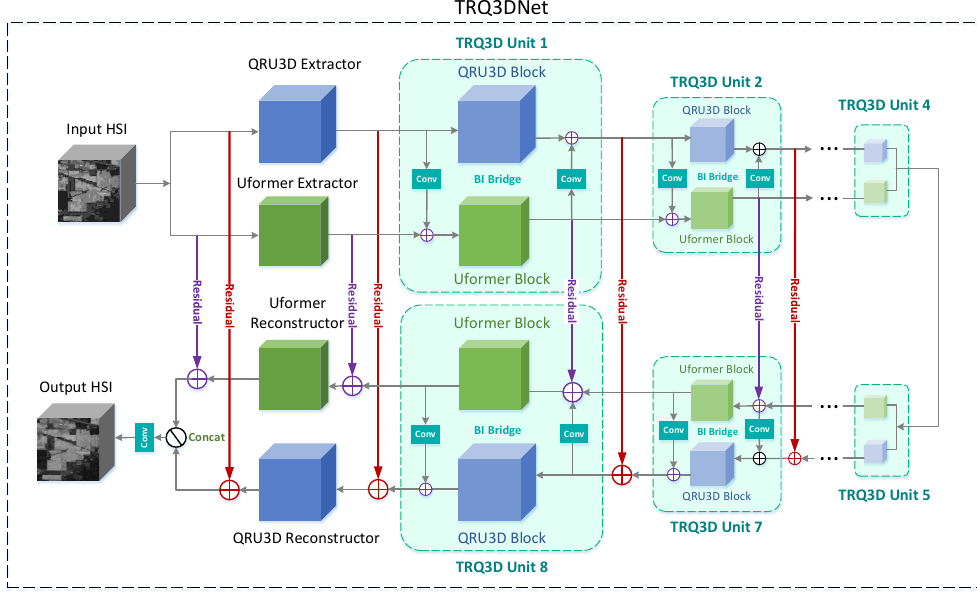
Figure 1. The overall architecture of the